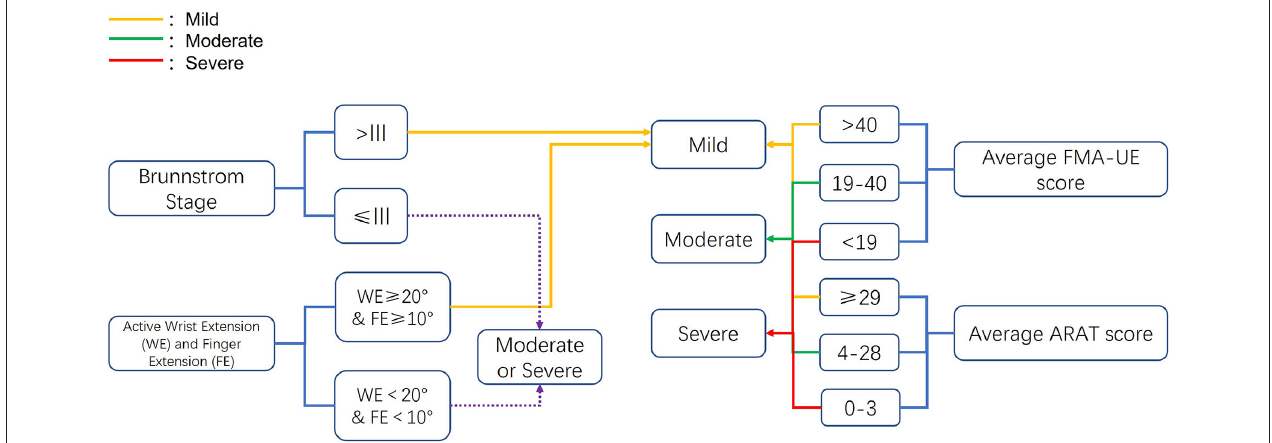
FIGURE 1 | Criteria for the upper extremity paresis severity classification. ARAT, Action Research Arm Test; FMA-UE, Fugl-Meyer Assessment of Upper